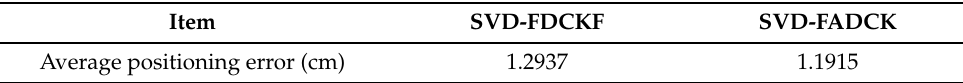
Table 3. Average positioning errors in 1500 Monte Carlo